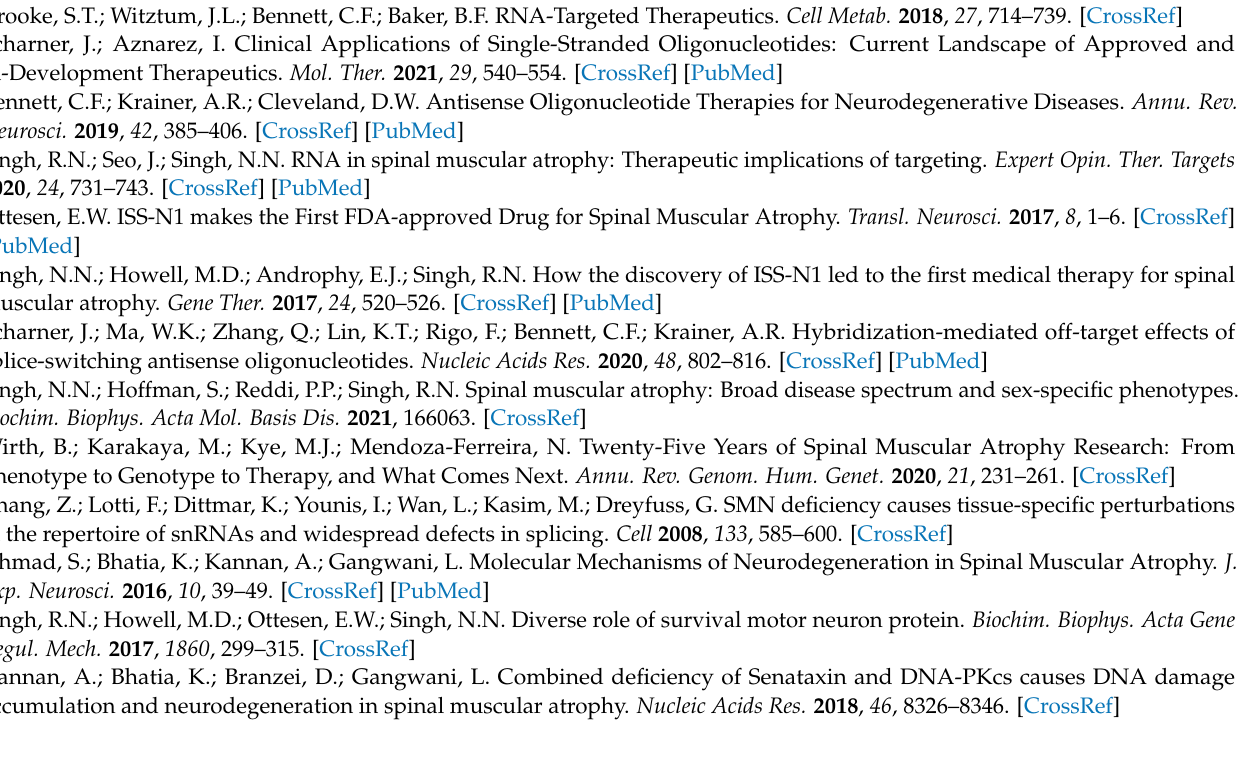
Table S3: Exon inclusion (EIN) events triggered by HiA treatment, Table S4: Exon inclusion (EIN) events triggered by LoA treatment, Table S5: Exon skipping (ESK) events triggered by HiA treatment, Table S6: Exon skipping (ESK) events triggered by LoA treatment, Table S7: Intron retention (IRT) events triggered by HiA treatment, Table S8: Intron retention (IRT) triggered by LoA treatment, Table S9: Increased intron removal (IRM) events triggered by HiA treatment, Table S10: Increased intron removal (IRM) events triggered by LoA treatment, Table S11: Exons with altered 5 (cid:48) splice sites (A5S) after HiA treatment, Table S12: Exons with altered 5 (cid:48) splice sites (A5S) after LoA treatment, Table S13: Exons with altered 3 (cid:48) splice sites (A3S) after HiA treatment, Table S14: Exons with altered 3 (cid:48) splice sites (A3S) after LoA treatment, Table S15: Mutually exclusive/mixed exons (MXE) altered after HiA treatment, Table S16: Mutually exclusive/mixed exons (MXE) altered after LoA treatment, Table S17: List of primers used for validation of alternative splicing and differential